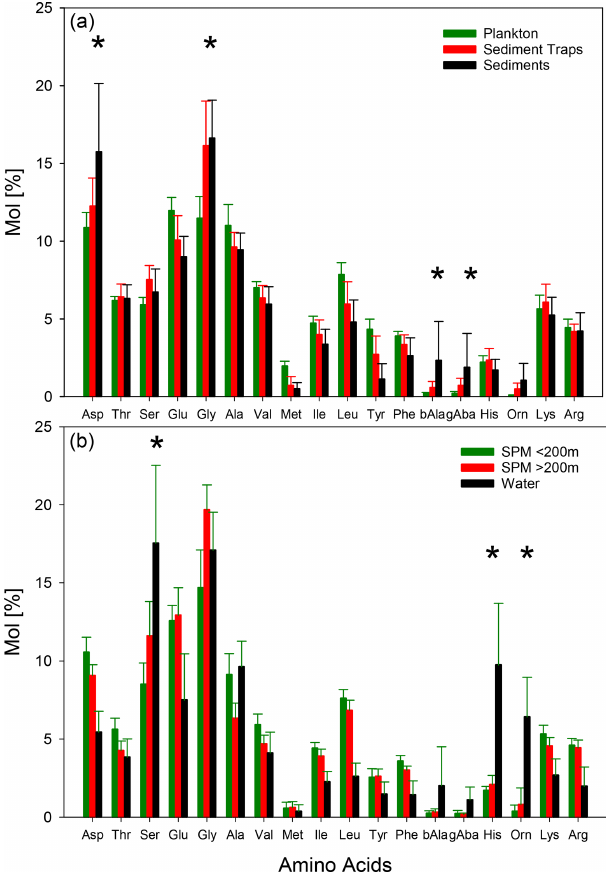
Figure 4. Average concentrations of individual AA (Mol%) and 1 σ standard deviation (vertical bars) in plankton (green), sediment trap (red), and sediment (black) samples (a) and in SPM from water depths < 200 (green), > 200m (red), and TDAA in water samples (black) (b) . Asterisks mark the AAs with increasing Mol% from plankton via sediment trap samples to sediments (a) and from shal- low SPM via deep SPM to TDAA of water